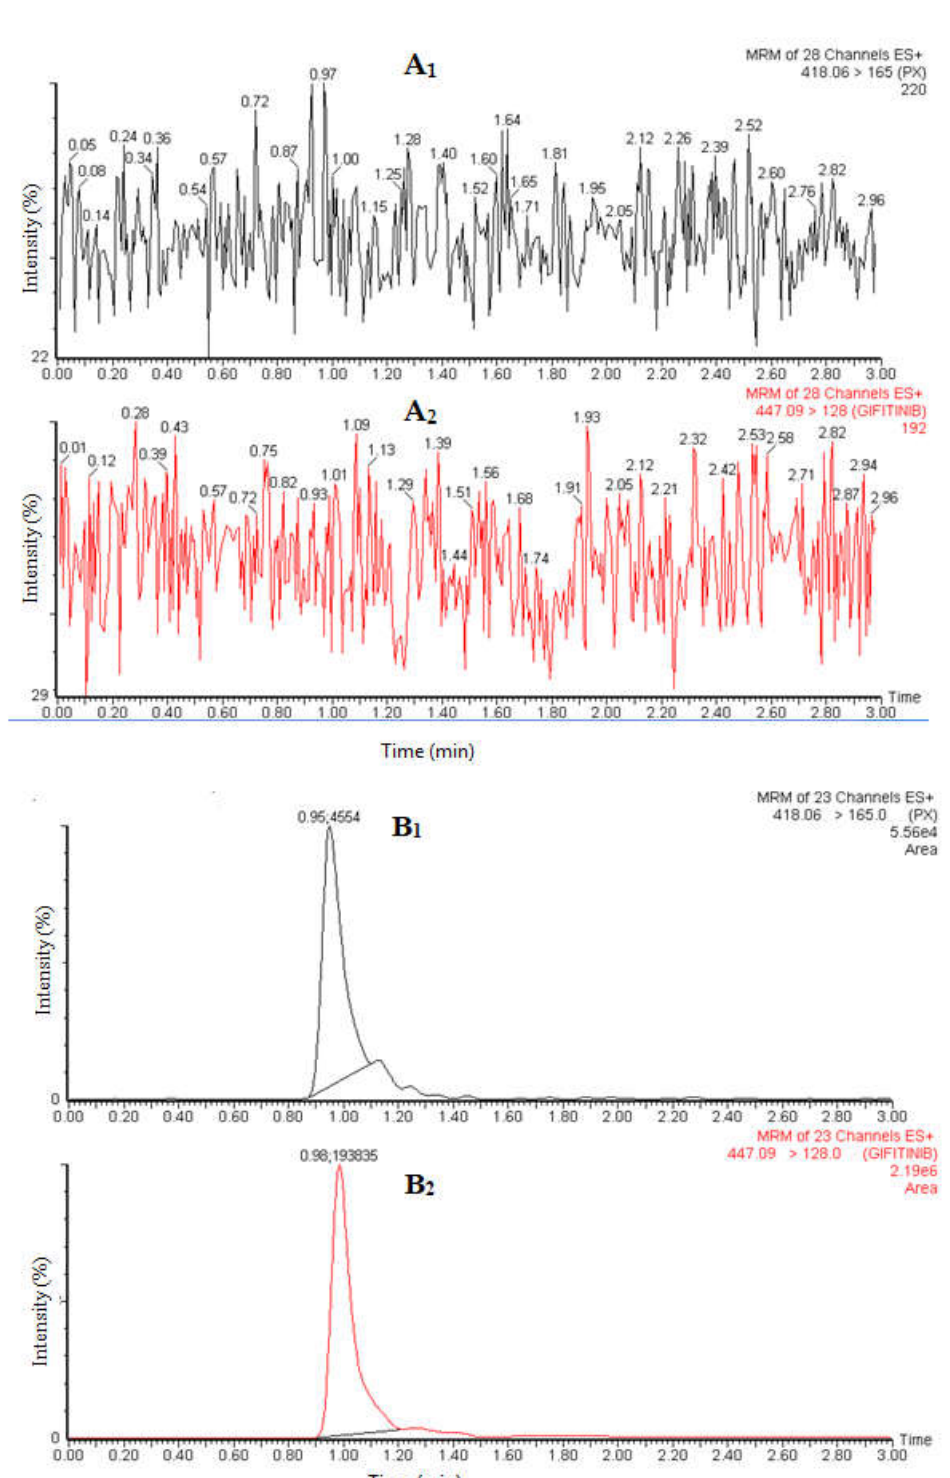
Figure 3. MRM chromatograms of PX and internal standard in blank plasma ( A ), and plasma spiked at LLOQ ( B ).